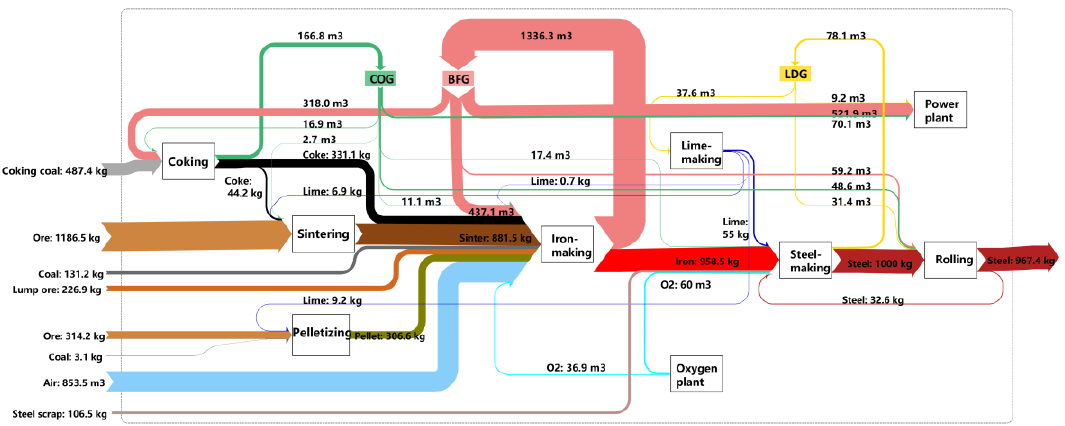
Figure 4. Chart of the material flows of a conventional ISP.